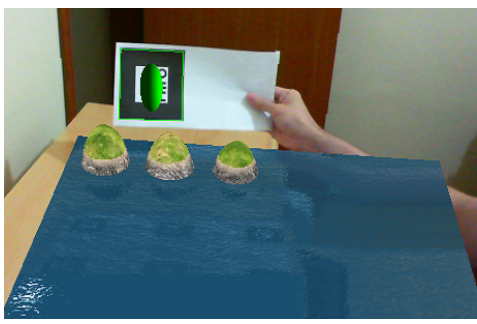
Fig. 10. Deformation using the ellipsoid volume function.